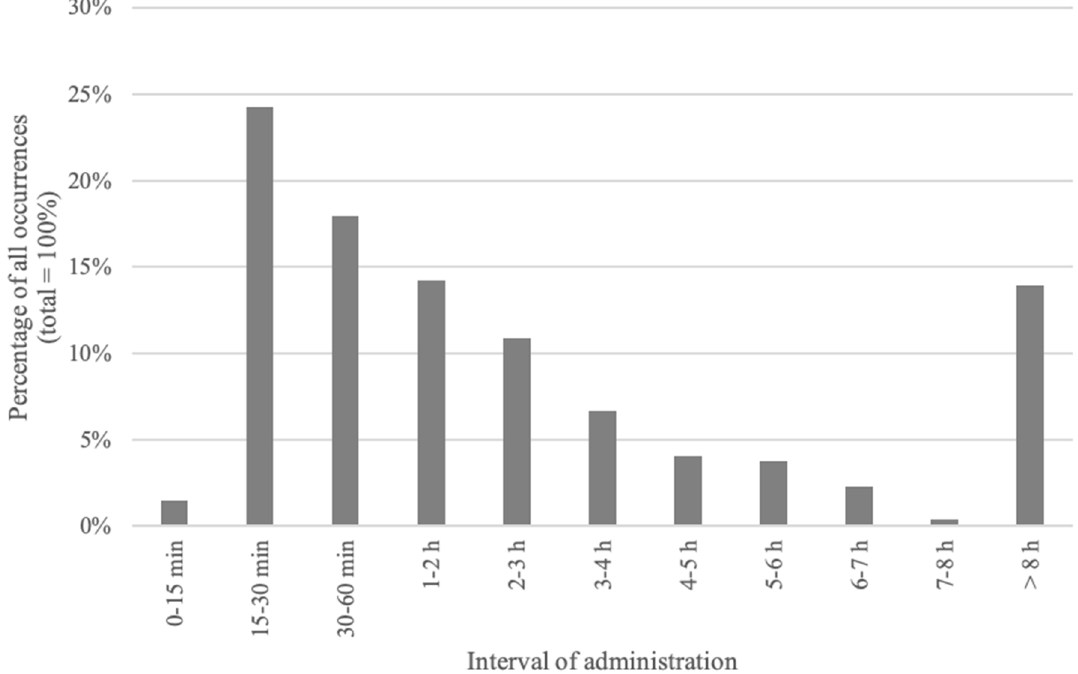
Figure 3. Interval between two OPD administration episodes.